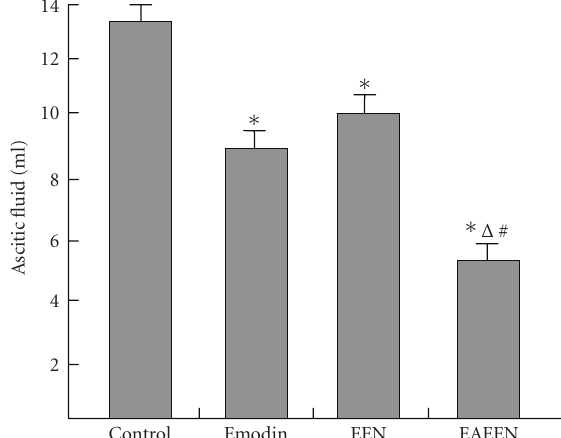
Figure 2: Changes of the amount of ascitic fluid in di ff erent groups. ∗ P < . 05 versus control group; Δ P < . 05, EAEEN group versus Emodin group; # P < . 05, EAEEN group versus EEN group. EEN: early enteral nutrition. EAEEN: emodin-assisted early enteral